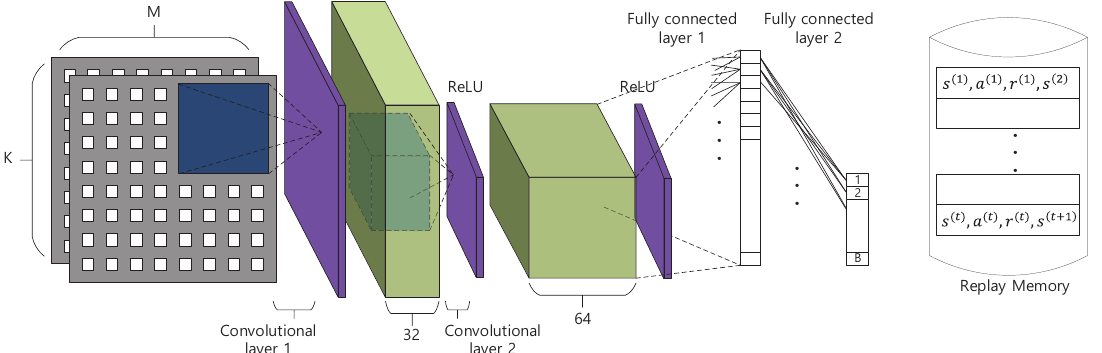
Figure 2. System model for beam selection using deep